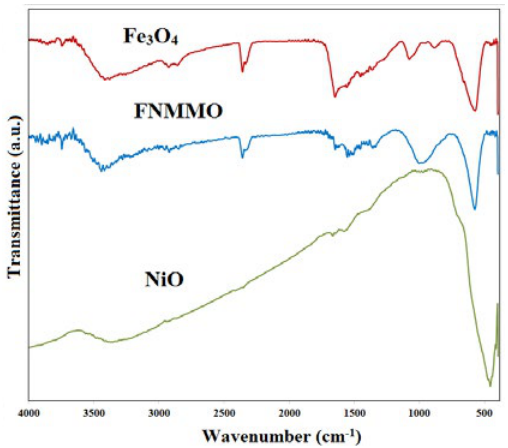
Fig. 4. FT-IR spectra for Fe